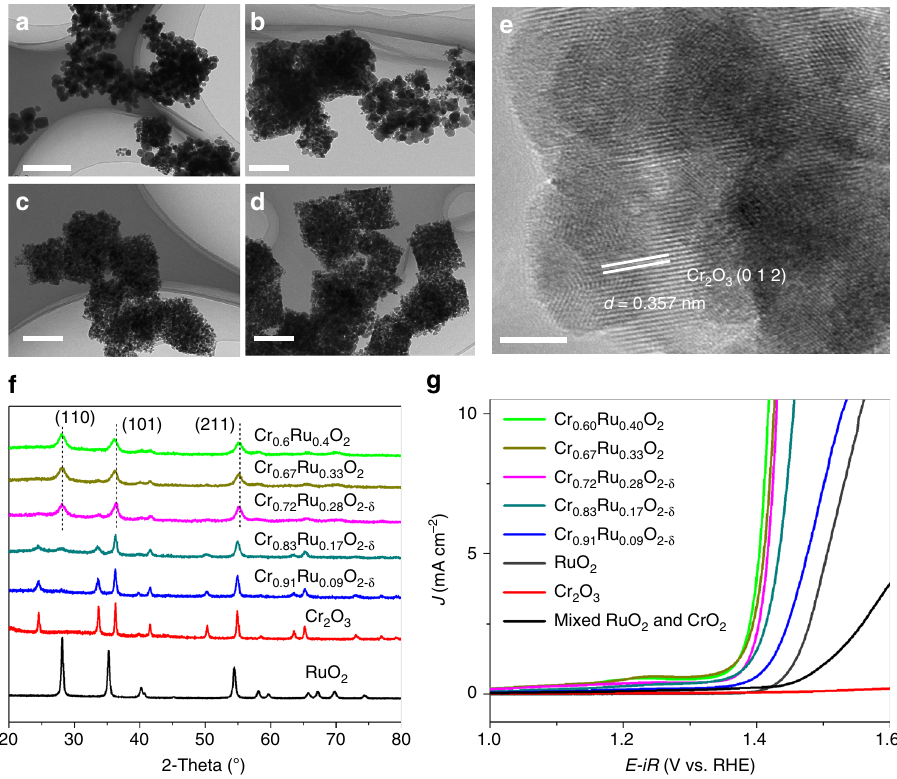
Fig. 5 Evolution of chromium – ruthenium oxides with different Cr/Ru ratios: a – d TEM images of Cr 0.91 Ru 0.09 O 2- δ , Cr 0.83 Ru 0.17 O 2- δ , Cr 0.72 Ru 0.28 O 2- δ and Cr 0.67 Ru 0.33 O 2 , respectively (scale bars, 200 nm); e HR-TEM image of Cr 0.83 Ru 0.17 O 2- δ (scale bar, 5 nm); f PXRD patterns, Cr 2 O 3 powder was obtained from directly annealing pure MIL-101 (Cr); g LSV